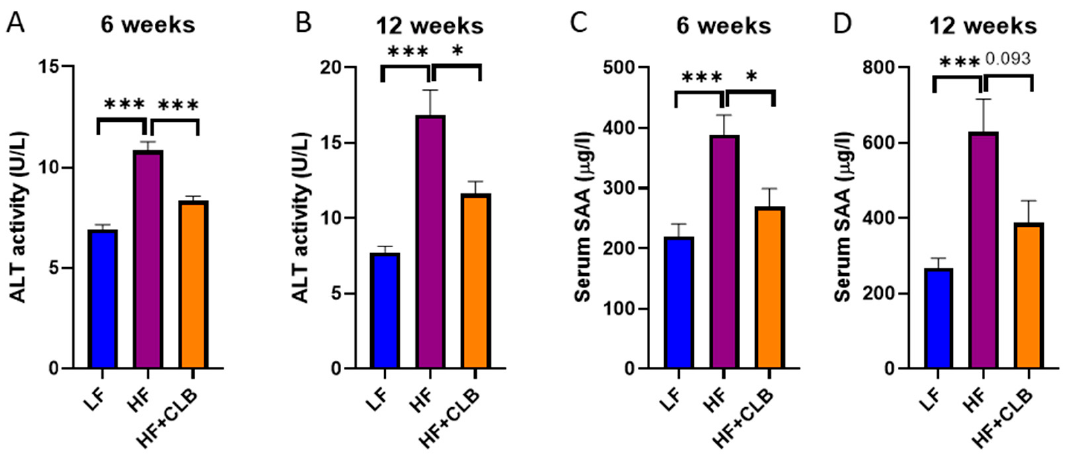
Figure 2. Liver function and systemic inflammation. Mice were divided into six groups to receive either a low-fat diet (10% of energy from fat, LF), high-fat diet (46% of energy from fat, HF), or cloudberry-supplemented high-fat diet (HF+CLB) for six ( A , C ) or twelve ( B , D ) weeks. The serum alanine aminotransferase (ALT) activity ( A , B ) is expressed as U/L. The level of serum amyloid A (SAA) in serum ( C , D ) is expressed as μ g/L. The data were analyzed with one-way ANOVA and Bonferroni post-test, * p < 0.05 and *** p < 0.001. The values represent mean + SEM, n = 12 mice per group.